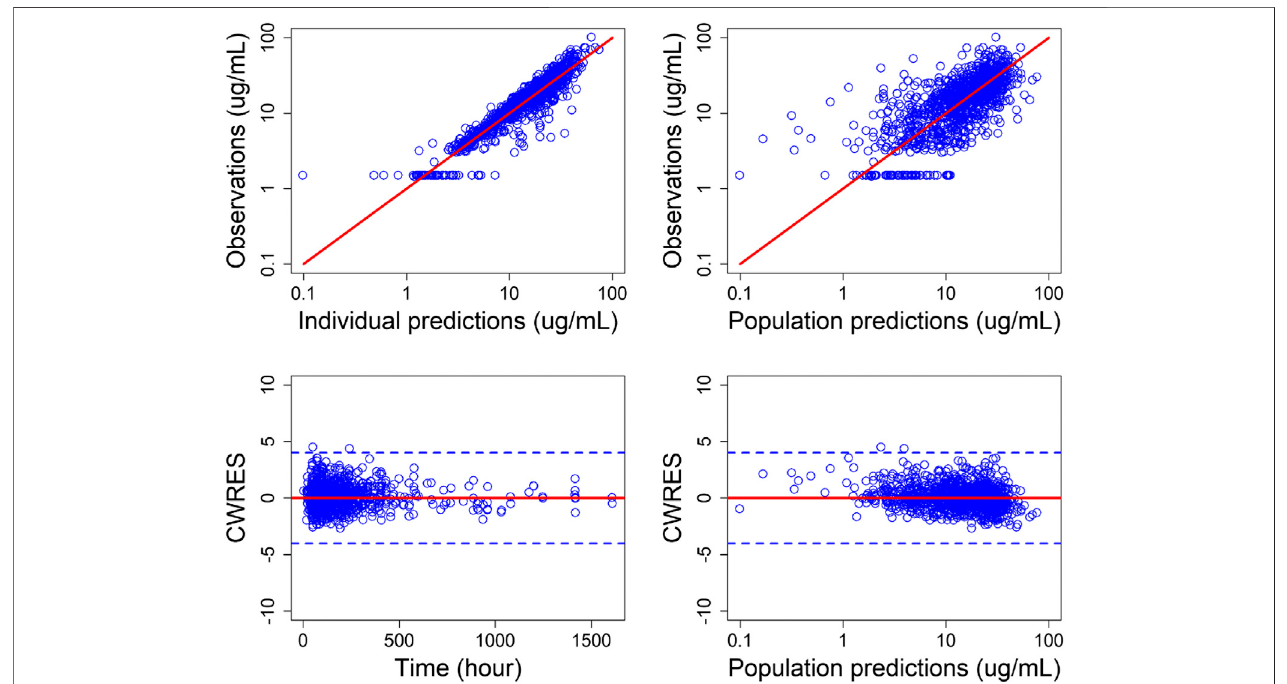
FIGURE 1 | Goodness-of- fi t plots for fi nal population PK model. Top: Individual predicted (IPRED) serum concentrations vs. observed concentrations (left) and population predicted (PRED) serum concentrations vs. observed serum concentrations (right) . Bottom: conditional weighted residuals (CWRES) vs. time (left) and PRED (right) . Points are individual data. Red solid lines represent the unit diagonal (top) or line at zero (bottom) . Blue dashed lines represent |CWRES| of 4.